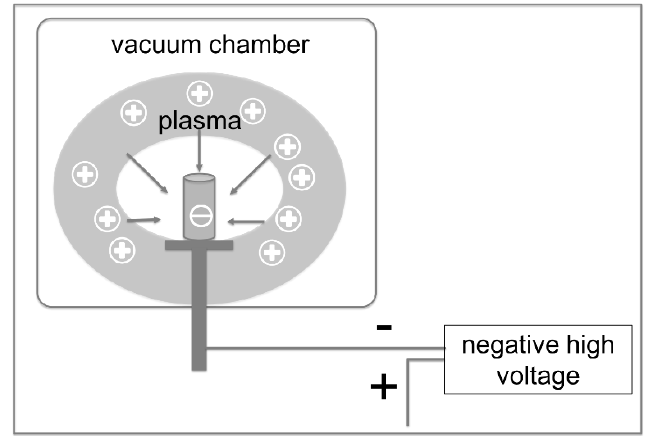
Figure 2. Schematic illustration of plasma immersion ion implantation. In a vacuum chamber, calcium ions are extracted from the plasma—i.e., ionized gas—and accelerated towards the negatively charged implant surface by applying a high voltage direct current.